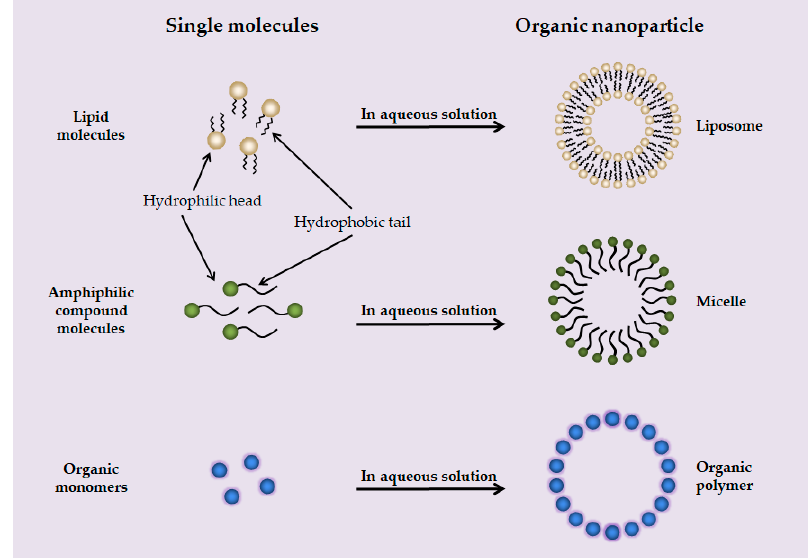
Figure 3. Structural sketches of liposome, micelle, and organic polymer. Liposomes are artificial membranes. The simplest form of liposome is the phospho- lipid bilayer formed with hydrophilic heads and hydrophobic tails [84]. Micelles are com- posed of amphiphilic compound molecules, the lipophilic tails of the molecules are con- centrated inside the micelles and the hydrophilic heads are exposed outside [85]. Organic polymers are organic polymer compound components in the form of nanospheres